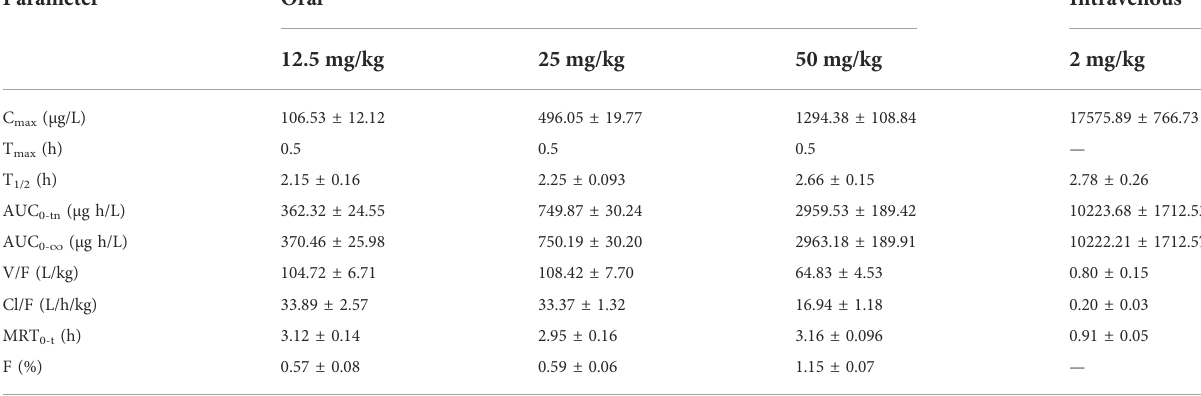
TABLE 6 Pharmacokinetic parameters of glytrexate following single oral and intravenous administrations ( n = 6). Parameter